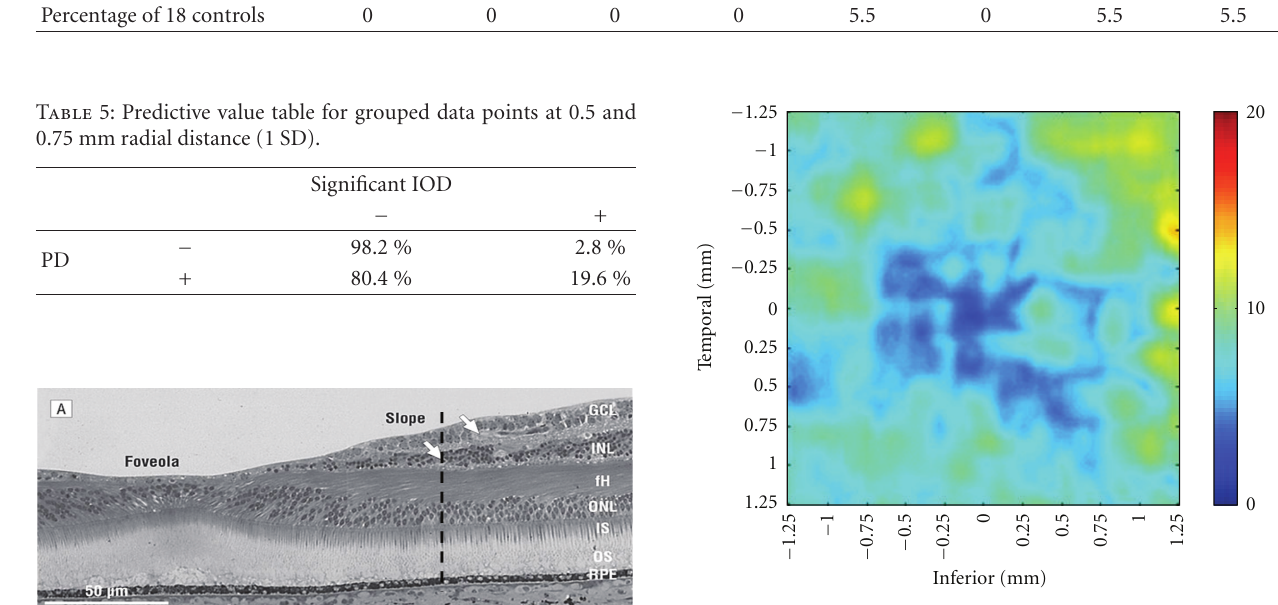
Figure 4: The mean interocular di ff erence map of all control subjects is depicted. Thickness measurements of the inner retina over the central grid of 2.5 × 2.5 mm were obtained, digitally reconstructed, and color-coded. Temporal side is on the left and nasal retina on the right side. Left eyes were reflected horizontally so that the temporal retina is directionally left and the nasal retina is directionally